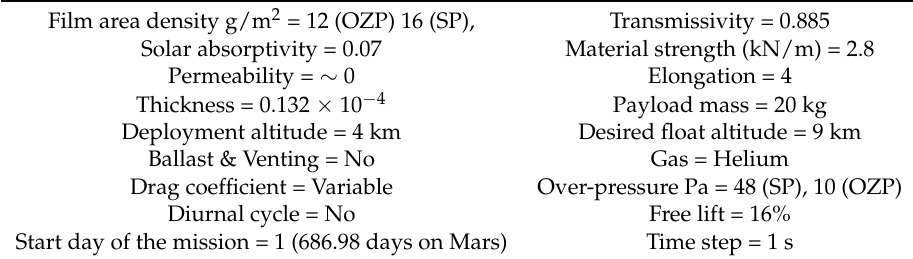
Table 5. Mars aerobot parameters. Parameters are based on [50,51,53].